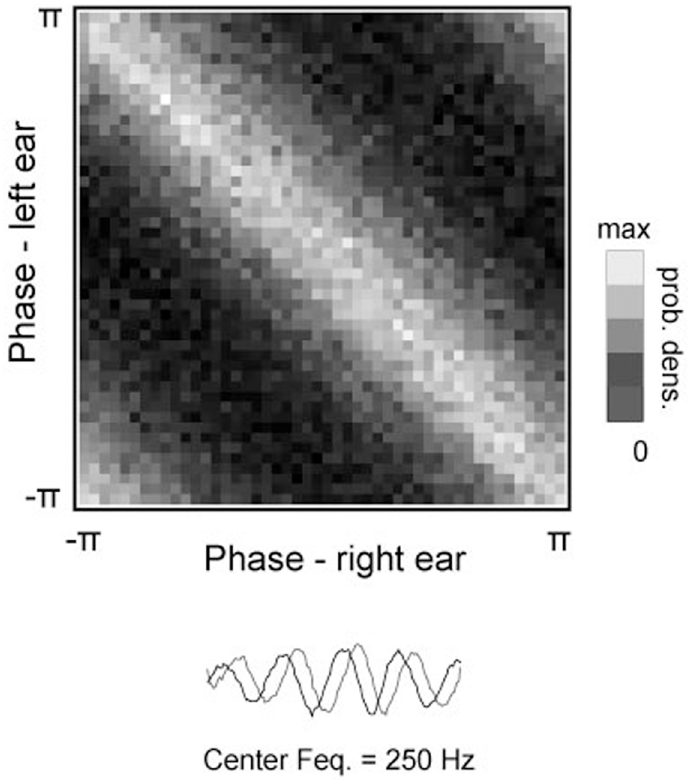
Fig 3. Joint distribution of monaural phases. The distribution was estimated by independently encoding left and right ear sounds from an ensemble of binaural sound epochs and creating a histogram of phase values associated with the basis function depicted at the bottom of the figure. Visible ridge-like pattern implies that monaural phases reveal a dependence in their difference.